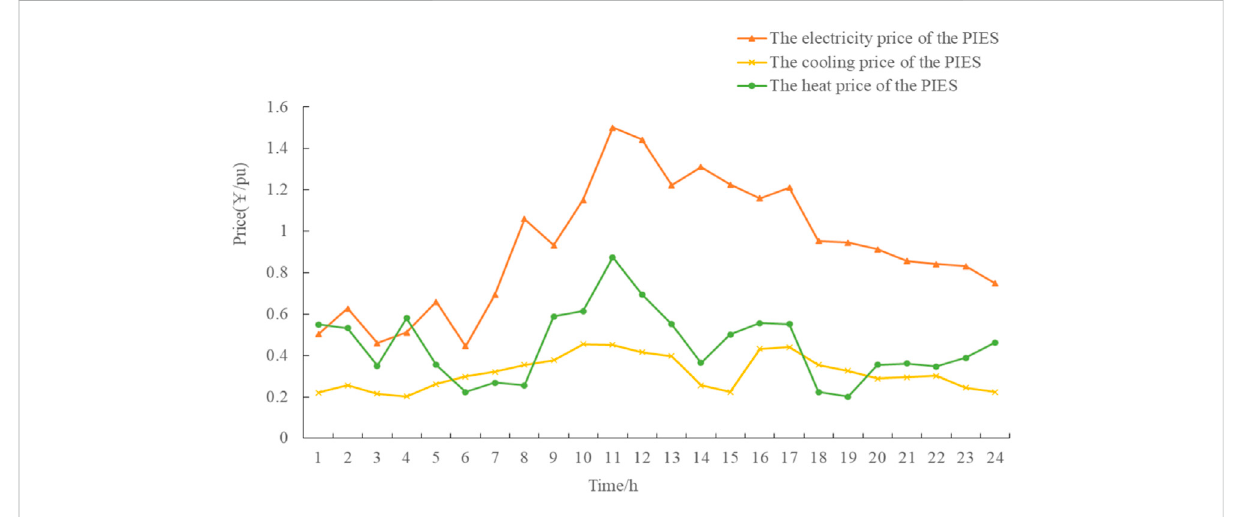
FIGURE 11 Price of PIES to